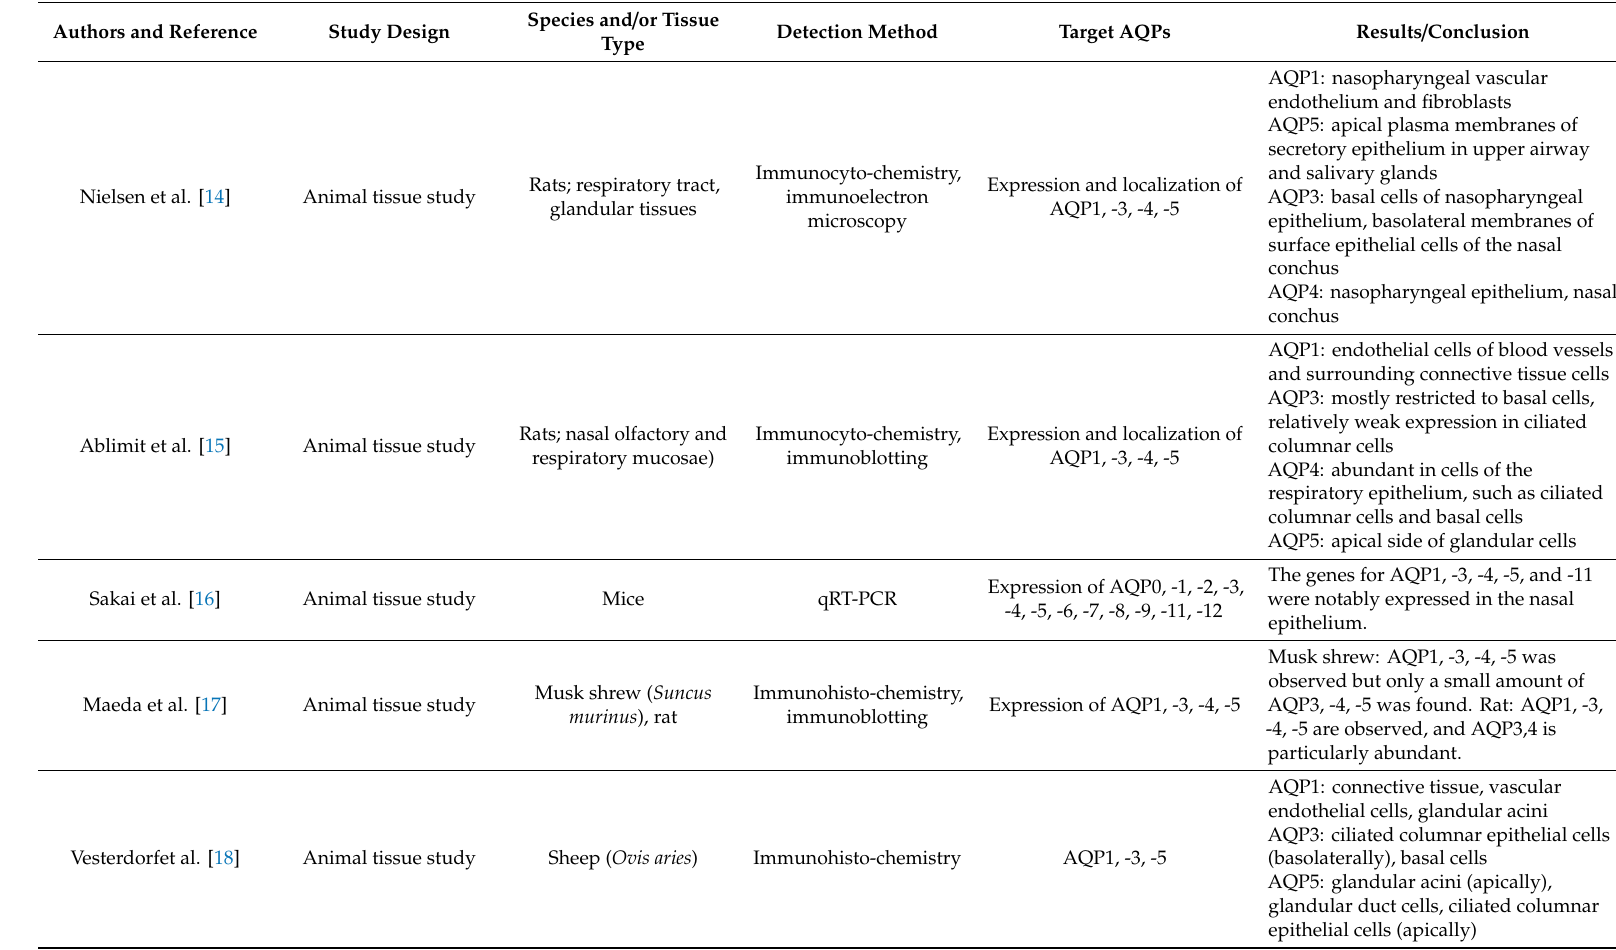
Table 1. Studies assessing the expression of aquaporins (AQPs) in normal respiratory epithelium of the nasal